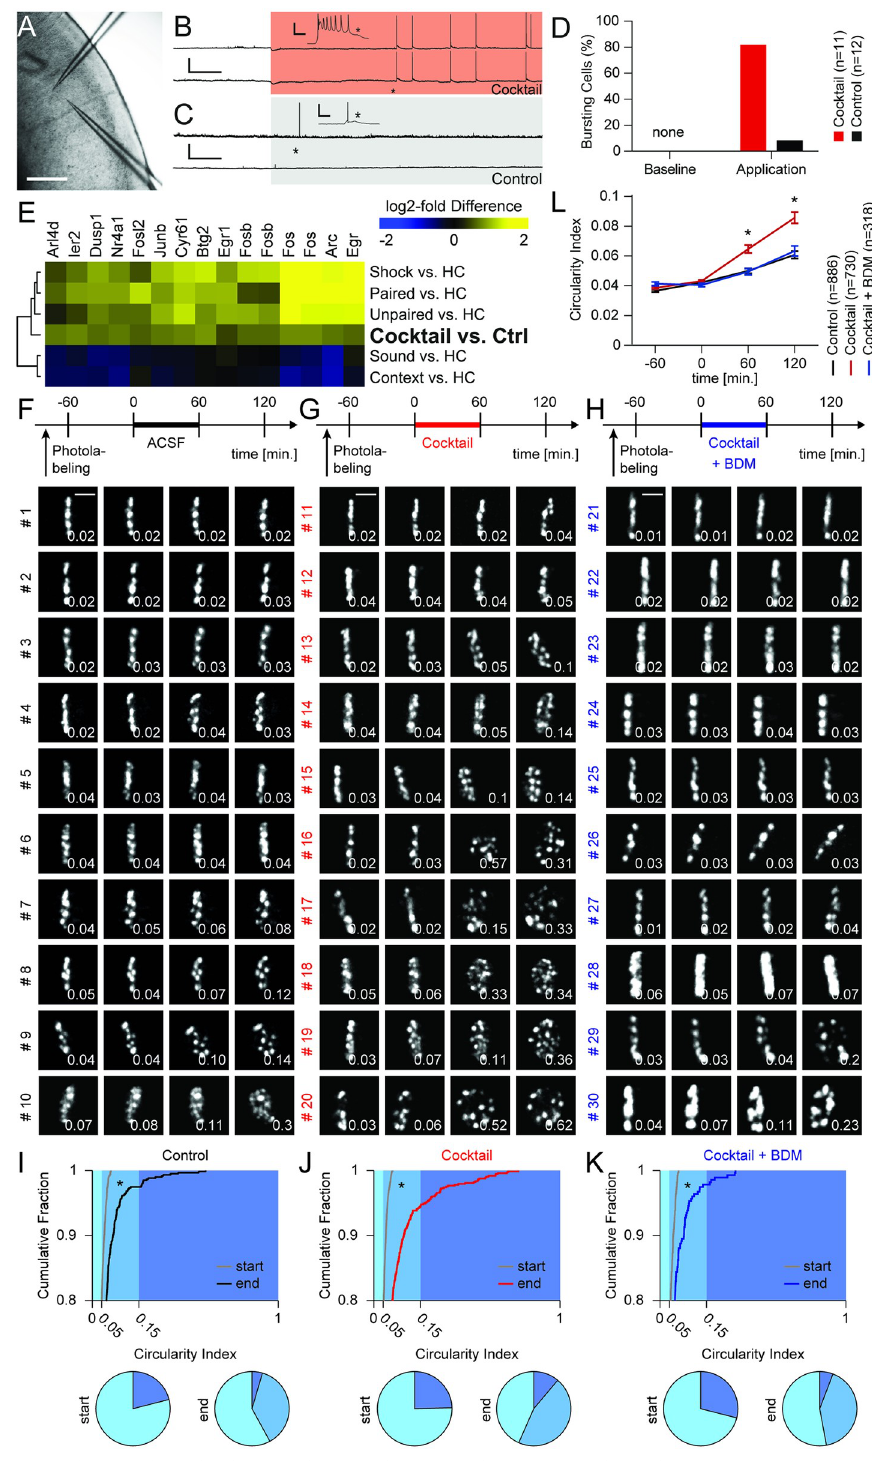
Fig 3. Pharmacological induction of neuronal activity in brain tissue induces chromatin reorganization. ( A ) Image of an acute brain slice of the auditory cortex from an H2B::PaGFP mouse with two patch pipettes illustrating recording configuration. Scale: 200 μ m. ( B ) Paired patch clamp whole-cell current-clamp recording of two neurons. Higher resolution of recordings indicated by asterisk. Red background indicates change of bath solution to ACSF containing a pharmacological cocktail driving synaptic transmission. Note, induction of highly synchronized busting